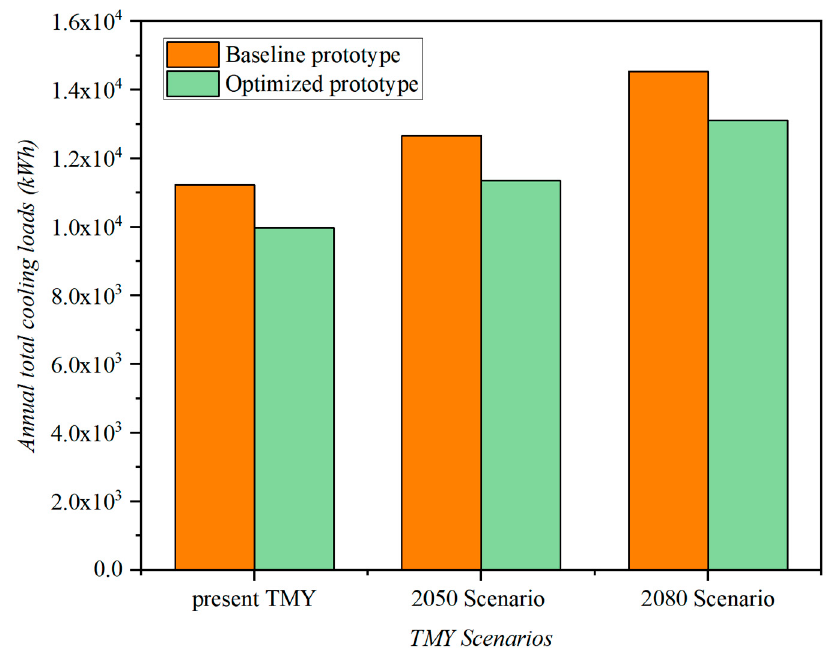
Figure 19. Annual total cooling loads of baseline and optimized prototypes upon present TMY and predicted future scenarios (2050 and 2080).